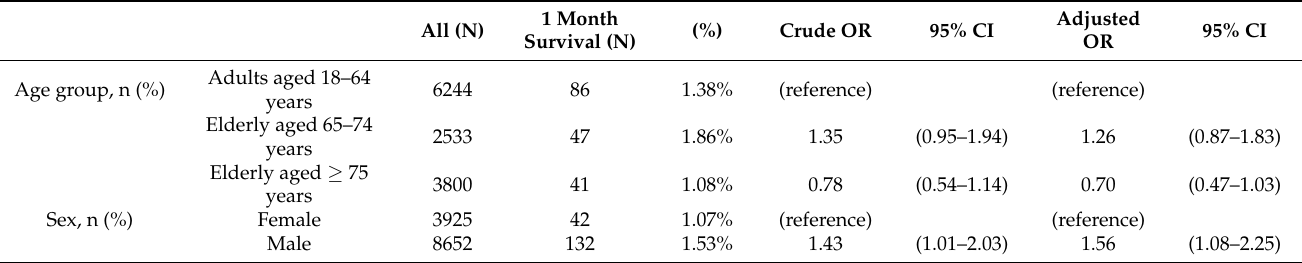
Table 4. Factors associated with primary